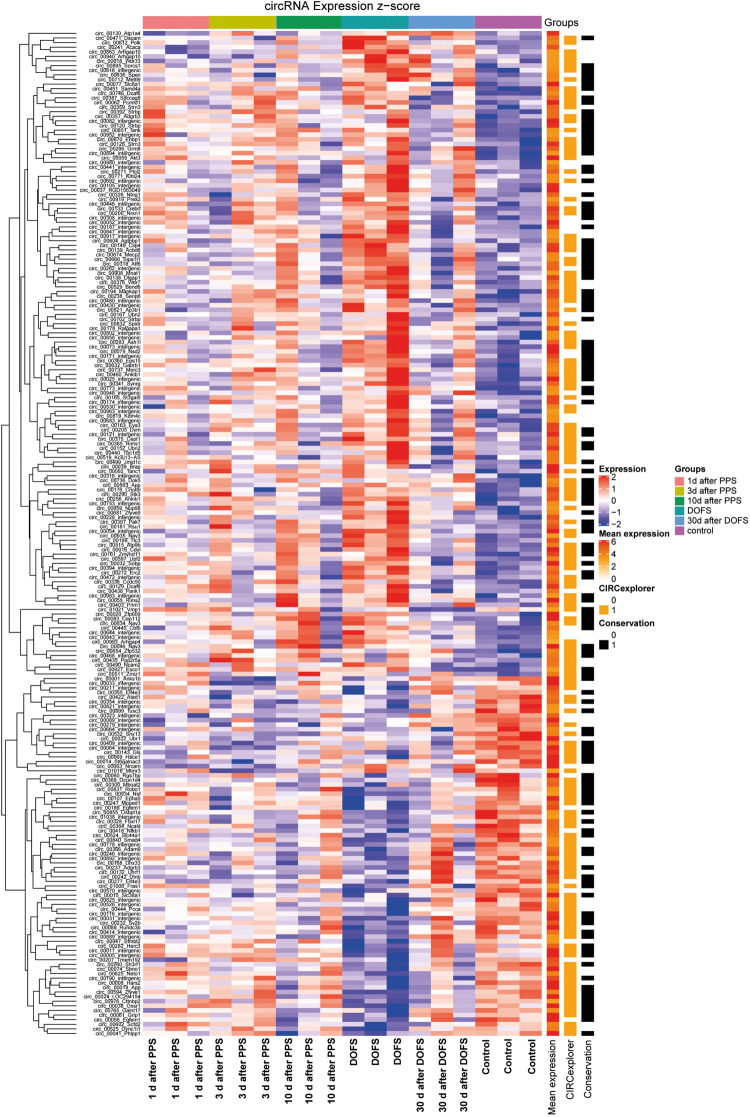
Differentially expressed circRNAs. Heatmap representation of circRNA detection, conservation and expression in the different experimental groups [1 day, 3 days, and 10 days after performant pathway stimulation (PPS); day of first spontaneous seizure (DOFS) and 30 days after DOFS; control]. All circRNAs with FDR < 0.05 for any time point relative to control group are shown. Expression (z-score) of each circRNA is represented in each cell, where z-score represents the number of standard deviations away from the mean [from –2 (blue) to 2 (red)]. Mean expression shows expression of each individual circRNA across all samples in log scale [low expression (white), medium expression (orange) or high expression (red)]. CIRCexplorer indicates if a specific circRNA is also found by the CIRCexplorer algorithm [found by CIRCexplorer (orange) or not (uncolored)]. Conservation specifies if a circRNA is conserved to mouse, according to circBase [conserved (black) or not conserved (uncolored)].